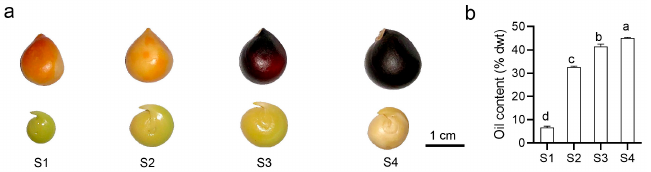
Figure 1. Seed size (top left in a ), embryo size (bottom left in a ), and oil content ( b ) of yellowhorn in S1, S2, S3, and S4. Scale bar = 1 cm. The seeds from the fruit were harvested at 25, 40, 55, and 70 days post-anthesis (dpa), abbreviated as the S1, S2, S3, and S4 development stages, respectively. The dwt represents dry weight. Data from oil content experiments were analyzed using Duncan’s multiple range test. Significant differences ( p -value < 0.05) are indicated by different lowercase letters.